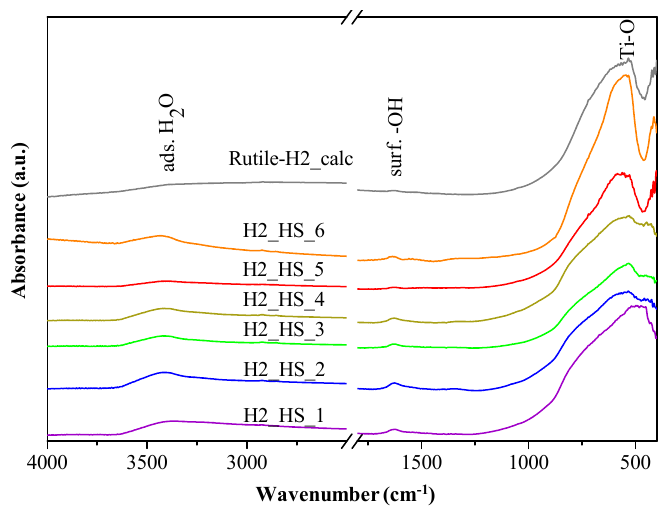
Figure 10. IR spectra of the investigated TiO 2 -s.